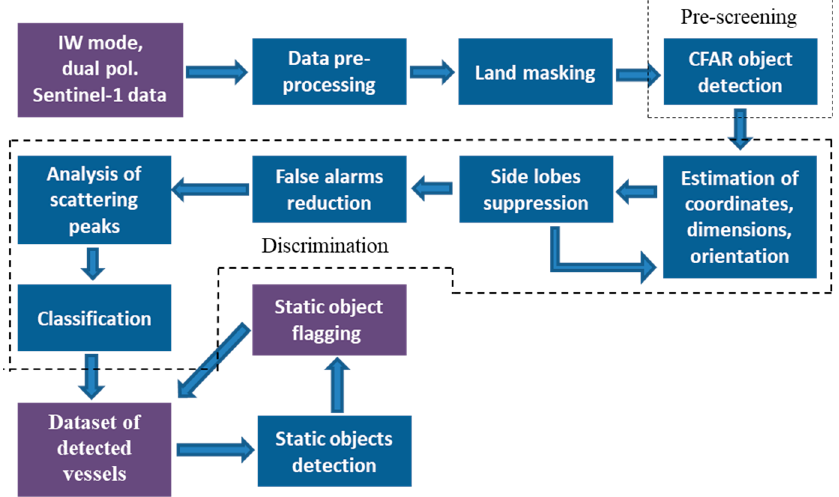
Figure 3. Sentinel-1 synthetic aperture radar (SAR) data processing and vessel detection chain.